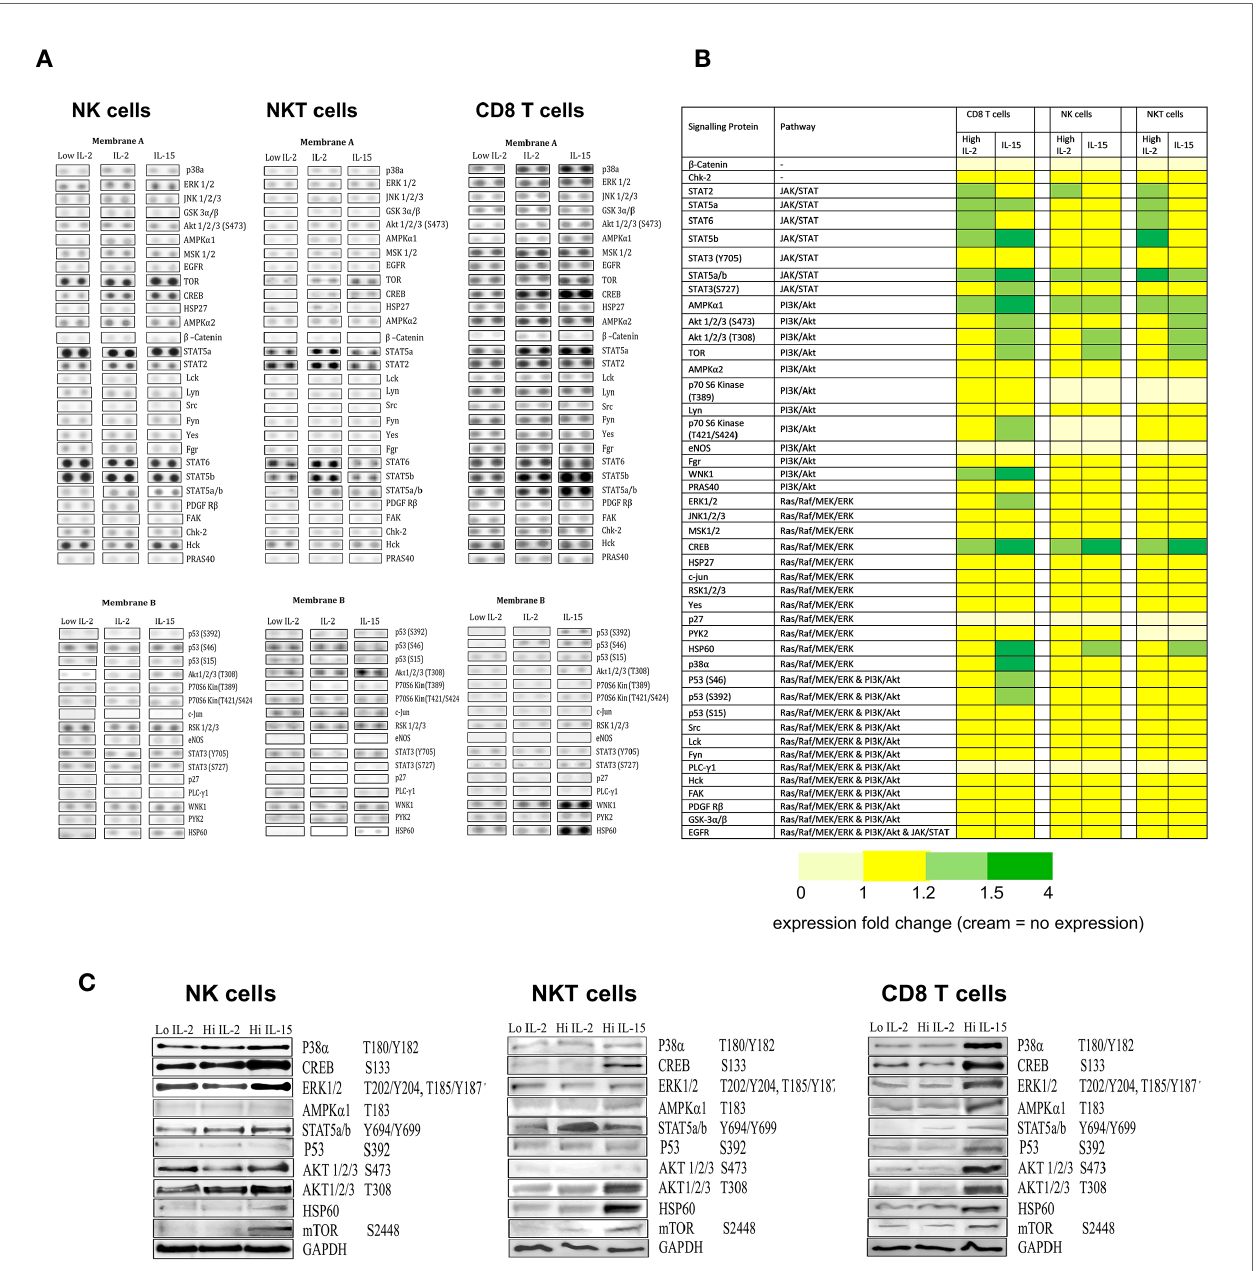
FIGURE 4 | The effects of IL-15 and IL-2 on the expression of phosphorylation of proteins from the three signaling pathways JAK/STAT, P13/AKT, and RAS/MAPK. (A) shows membrane dot images developed from probing of the three cell types (NK, NKT, and CD8 T cells) treated with 1ng/ml IL-2 with the two membranes from a representative donor. The intensity of the dots relates to the detection of phosphorylated protein intensity within a certain sample. (B) displays a heatmap of the protein array collated from repeated experiments (n=4), with the proteins arranged by their signaling pathways and with colors indicating the degree of upregulation of phosphorylated proteins as calculated by densitometry carried out on the developed membranes. Yellow represents no change in expression compared to the low dose IL-2 control. Light green = protein expression increased by 1.1 fold -1.5 fold. Dark green = expression increased by more than 1.5 fold. Cream indicates no protein expression. (C) displays western blots of proteins selected from the array that showed increased phosphorylation (or upregulation of protein in the case of